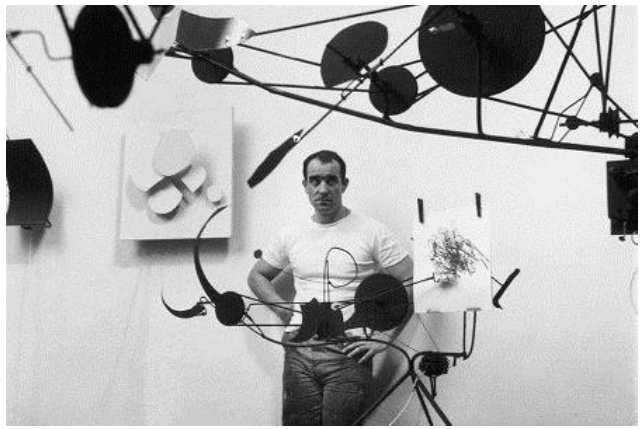
Figure 7. Jean Tinguely in his atelier in 1959. Martha Rocher/ Museum Tinguely ,